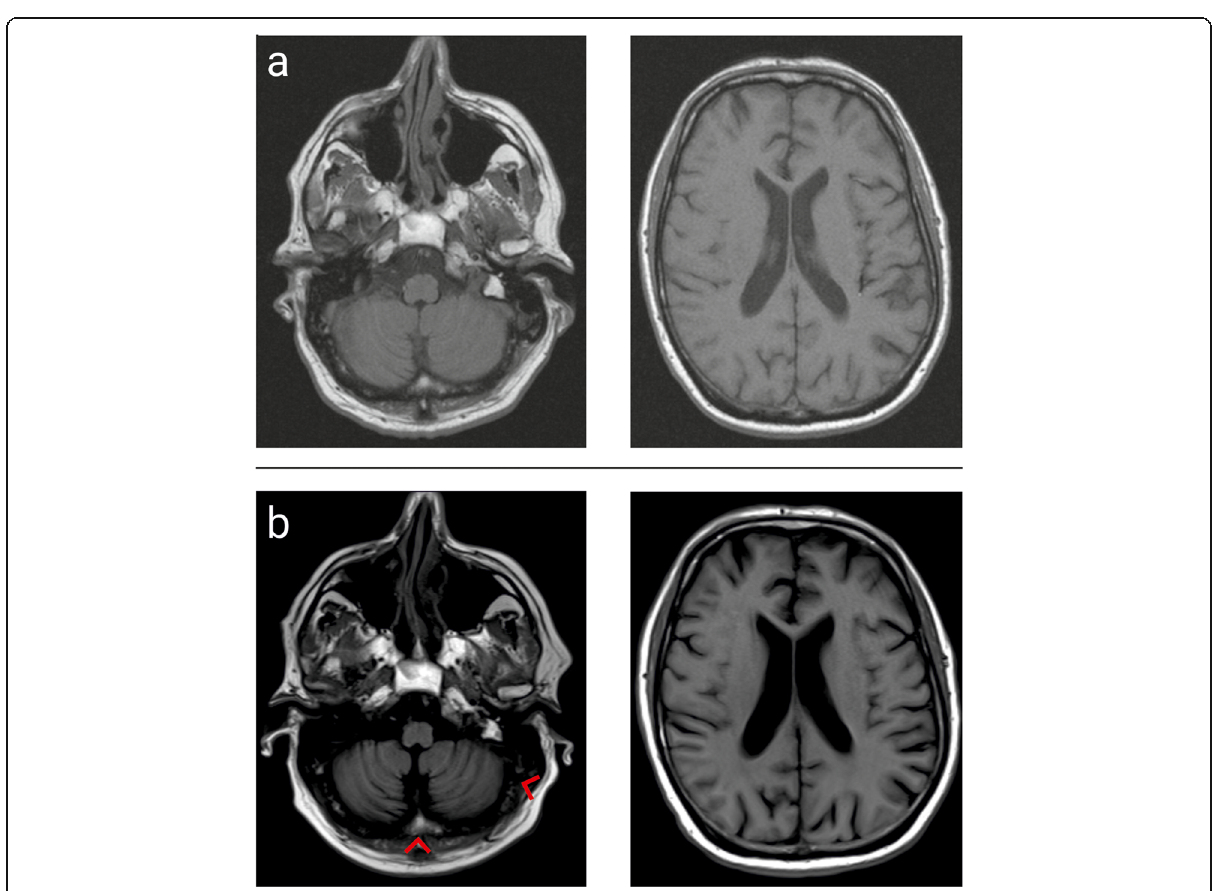
Fig. 1 Magnet Resonance Imaging shows progressive atrophy of the cerebellum (indicated by the red arrows) on T1-weighted Turbo spin echo imaging at 10 months ( a ) and 16 months ( b ) after the onset of symptoms, indicative of progressive neurodegeneration. Figure designed with Corel Draw × 8 (Corel Corporation, Ottawa,